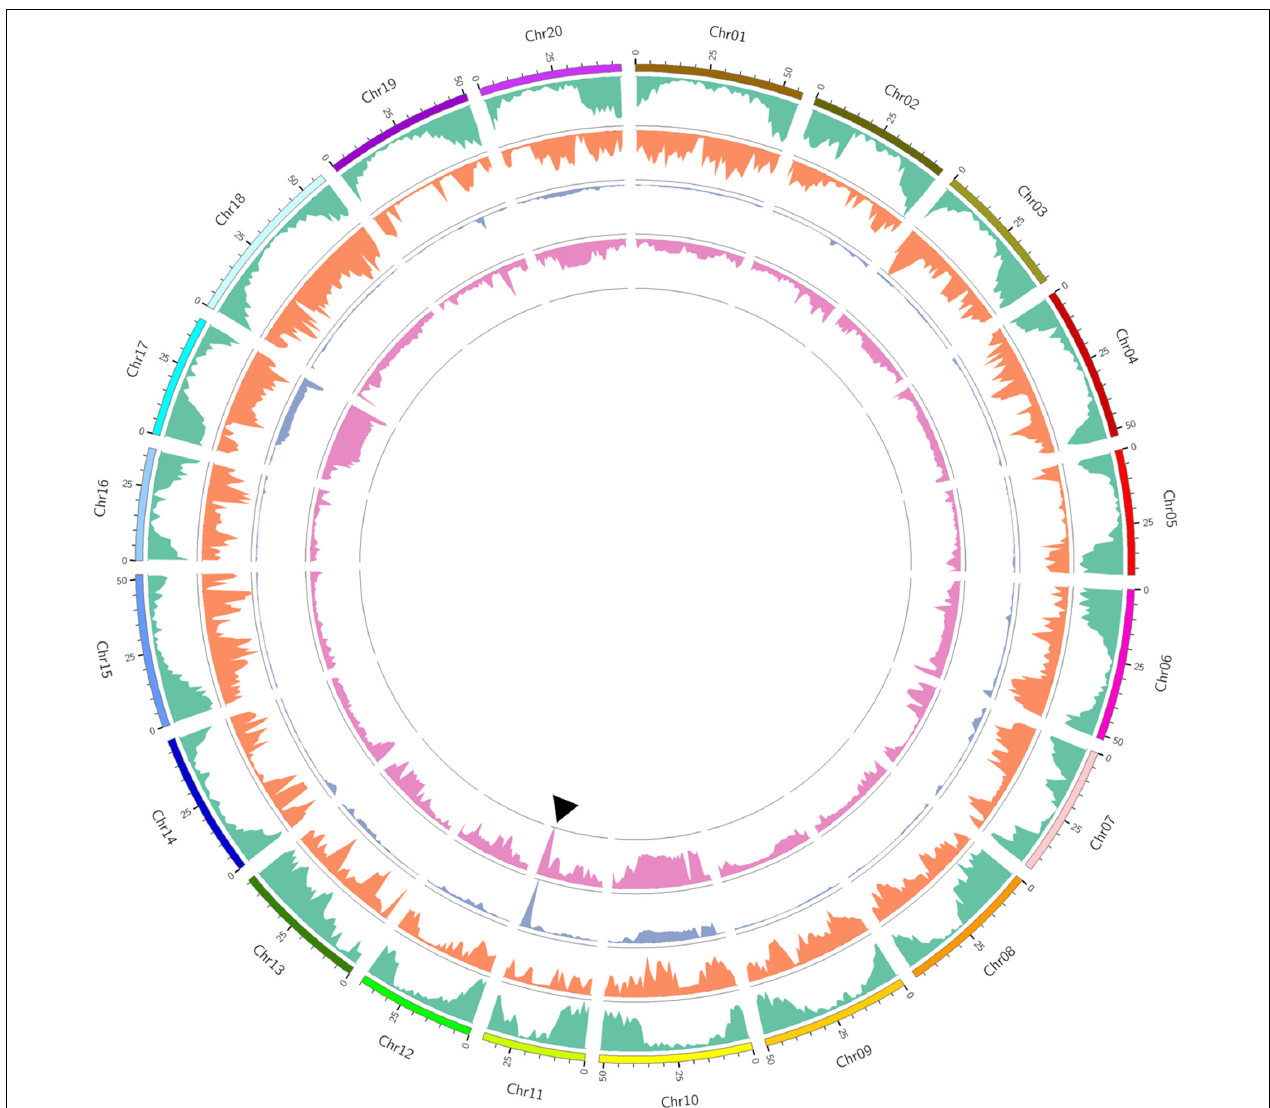
FIGURE 1 | Bulked segregant analysis (BSA)-seq analysis of the recombinant inbred line (RIL) population. Outer to inner circles: chromosome distribution, gene distribution (green color), single-nucleotide polymorphism (SNP) density distribution (orange color), euclidean distance (ED) value distribution (cyan color), and (cid:49) SNP-index distribution (rose color). The solid triangle indicates the peak position of the overlapping genomic regions at Gm11 using both ED and (cid:49) SNP-index